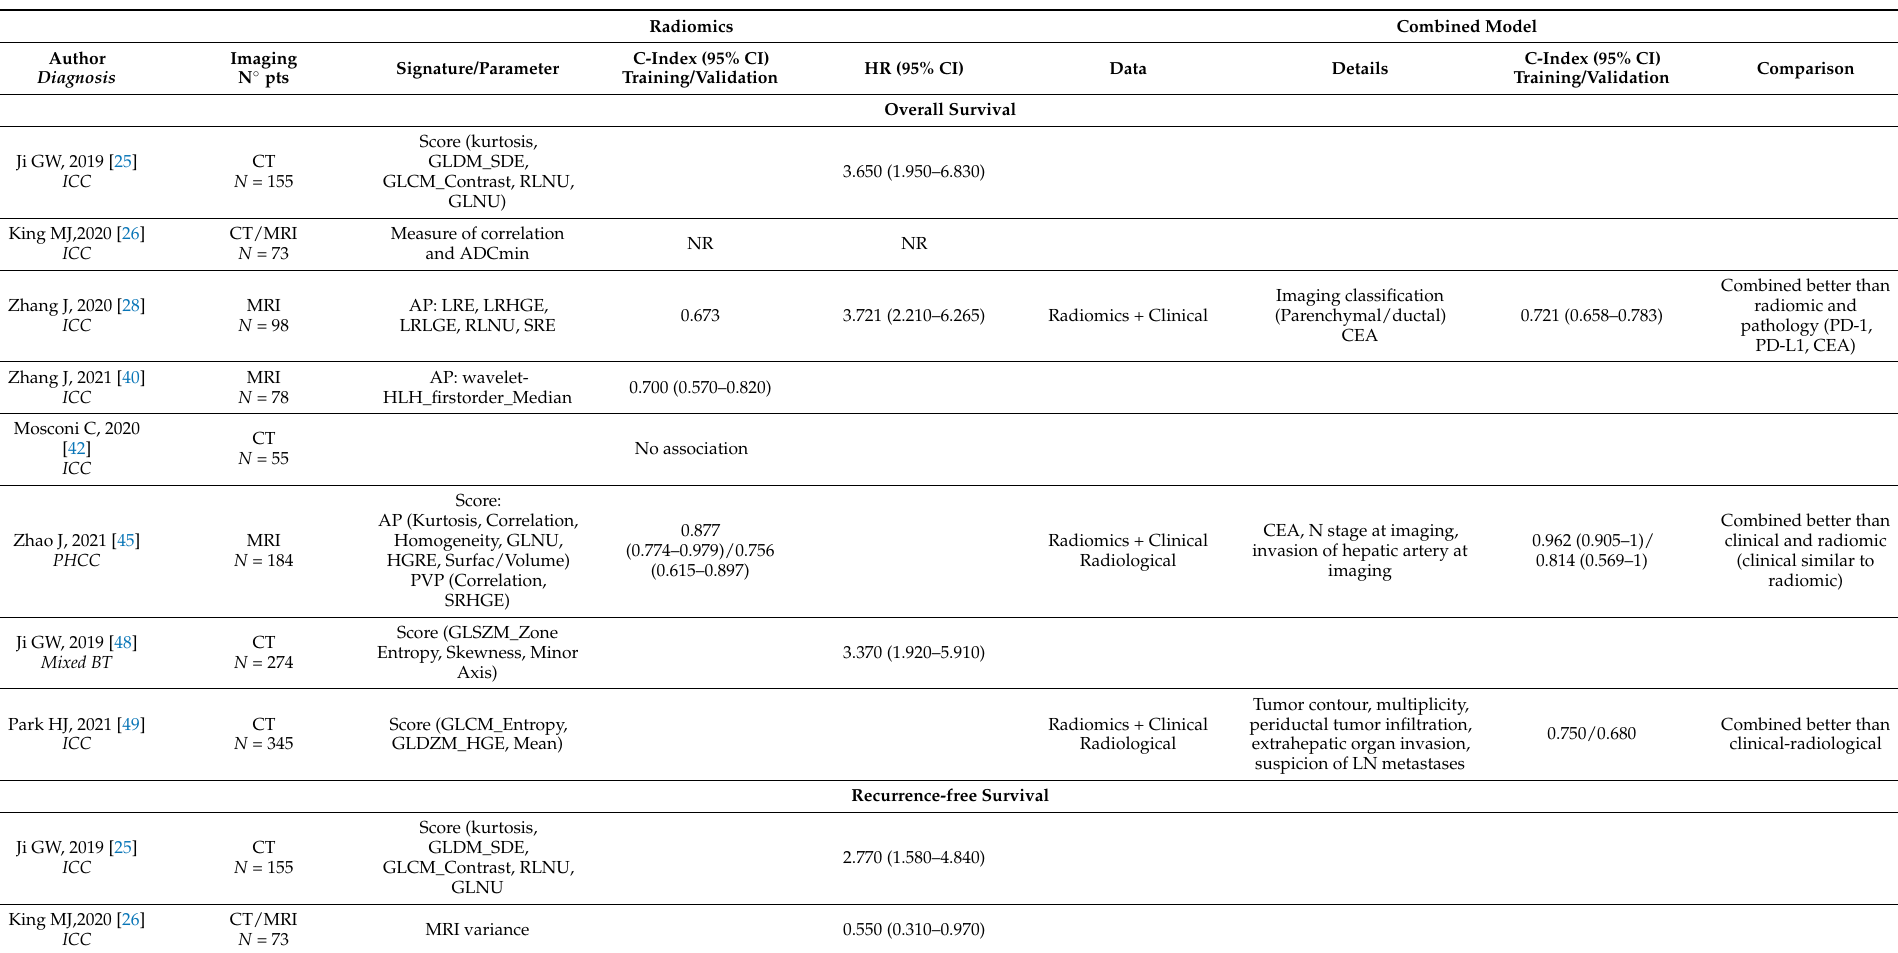
Table 4. Survival data: overall and recurrence-free